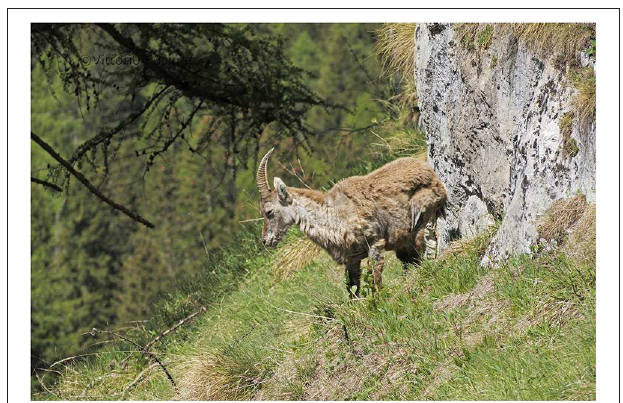
FIGURE 5 | Severe sarcoptic mange in an Alpine ibex ( Capra ibex ) from NE Italy. Macroscopically, lesions are characterized by severe, multifocal to coalescing, chronic hyperplastic dermatitis with alopecia and lichenification. Courtesy of Mr. Vittorio